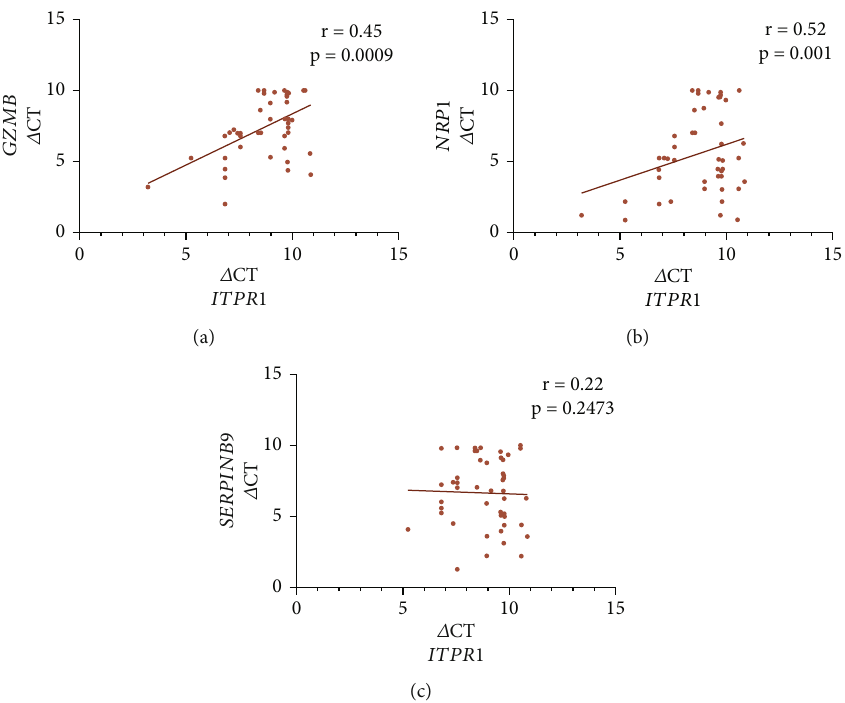
Figure 4: Correlation of ITPR1 transcripts with GZMB , NRP1 , and SERPINB9 transcripts in GV patients. The correlation of ITPR1 transcripts with GZMB , NRP1 , and SERPINB9 transcripts were analyzed by Spearman ’ s correlation analysis. (a) ITPR1 transcripts positively correlated with GZMB transcripts in GV patients ’ Tregs ( r = 0 : 45 , p = 0 : 0009 ). (b) ITPR1 transcripts positively correlated with NRP1 transcripts in GV patients ’ Tregs ( r = 0 : 52 , p = 0 : 001 ). (c) No correlation was observed between ITPR1 transcripts and SERPINB9 transcripts in GV patients ’ Tregs ( r = 0 : 22 , p = 0 : 2473